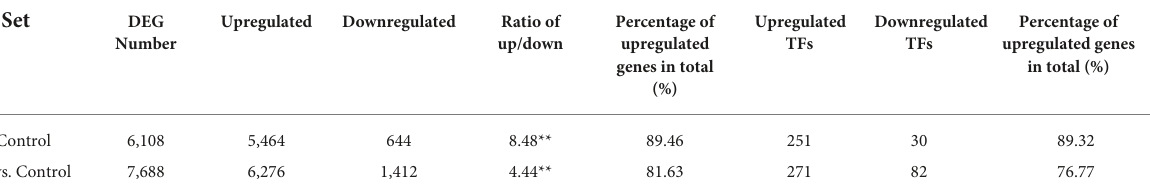
TABLE 5 Statistical of differentially expressed gene